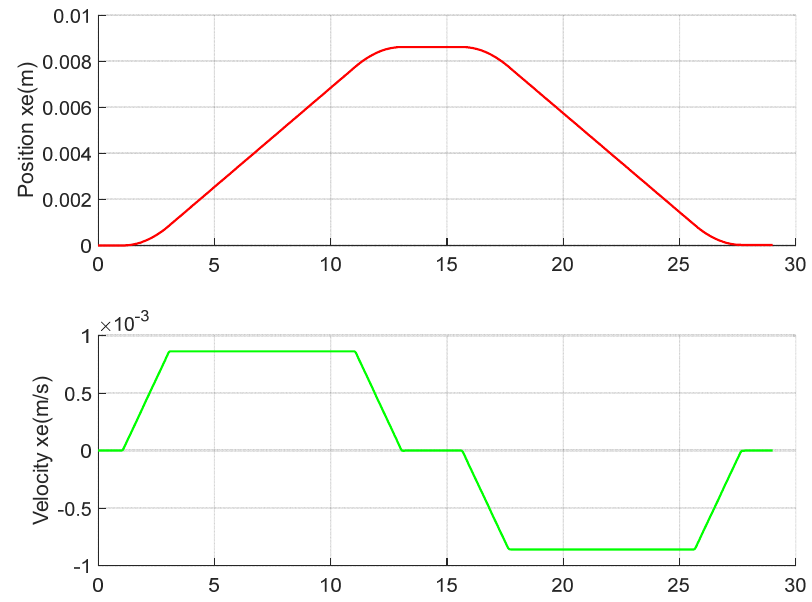
Figure 6. The external load x 4 , compensator disturbance x 5 , and their errors ˆ e 4 , ˆ e 5 for observer.